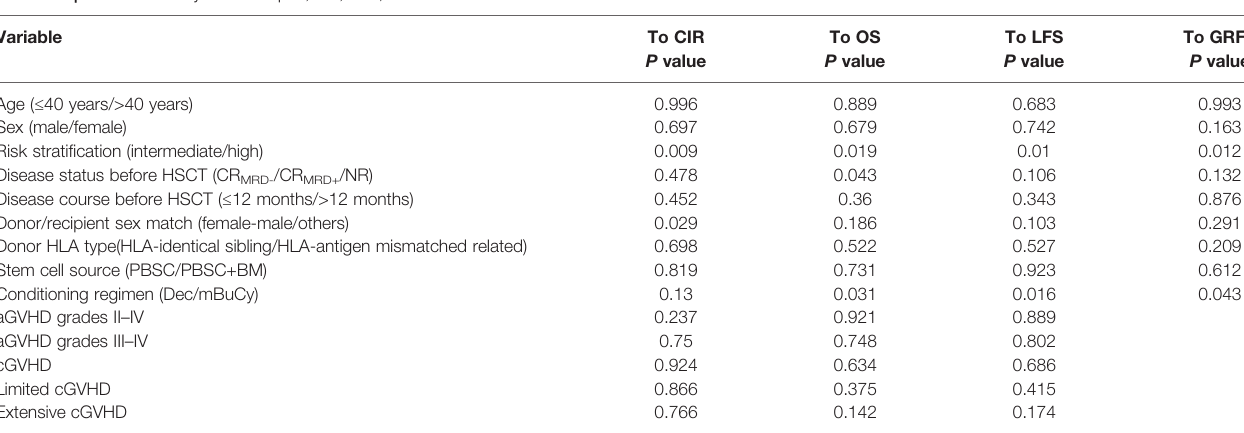
TABLE 4 | Univariate analysis for relapse, OS, LFS, and